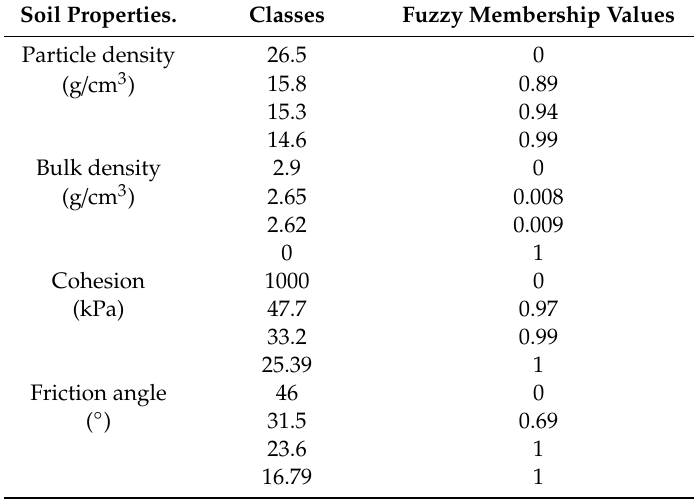
Table 5. Geomechanical properties whose decreasing tendency makes the site more susceptible to landslides: particle and bulk densities, internal angle of friction, and cohesion.